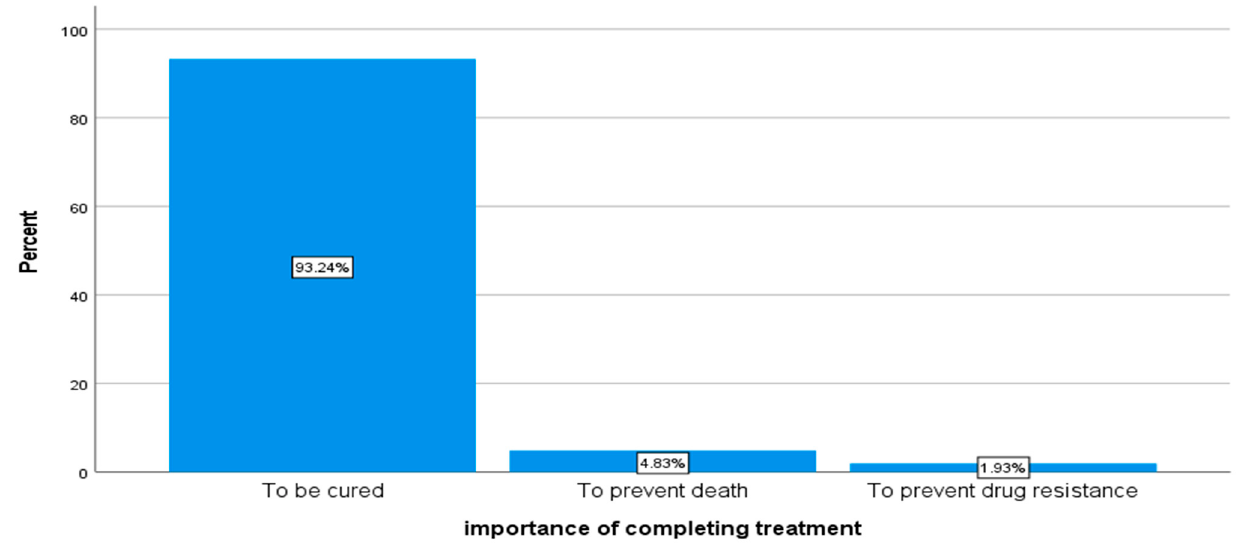
Figure 3. Importance of completing TB treatment ( n = 207).